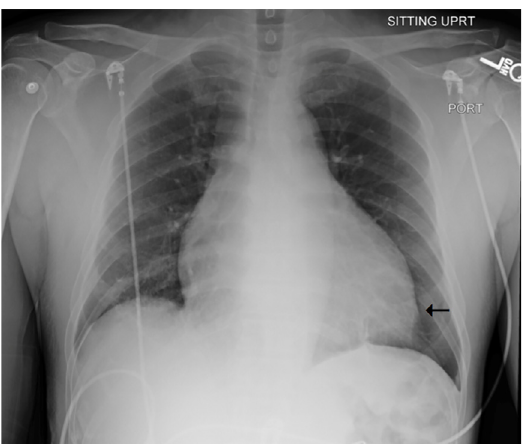
Image 2. Chest radiograph demonstrating cardiomegaly (arrow) but no vascular congestion.